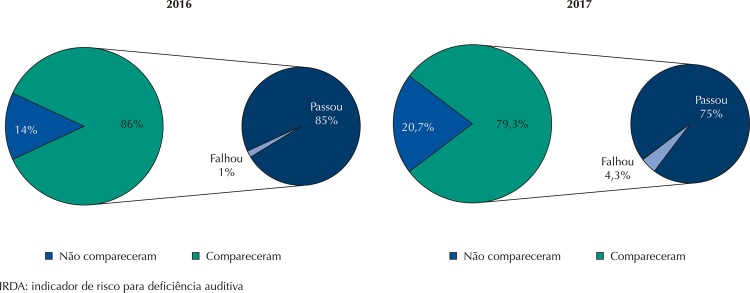
Prevalência de comparecimento, passa e falha no reteste de recém-nascidos com IRDA nos anos de 2016 e 2017.